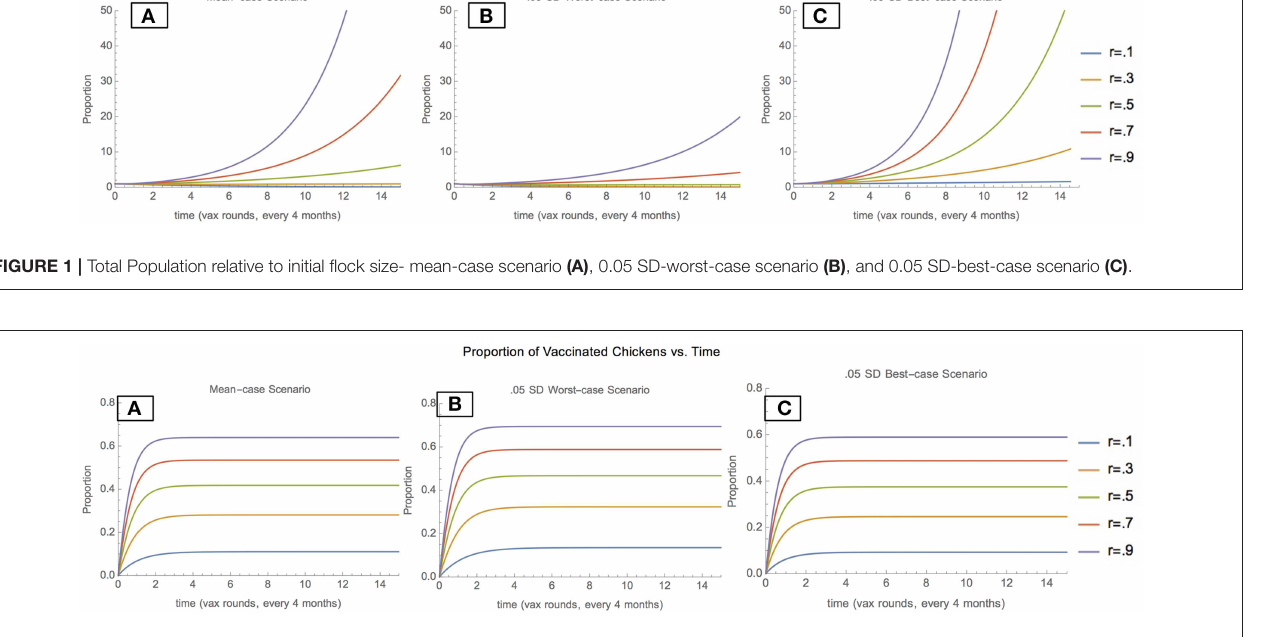
FIGURE 2 | Proportion of vaccinated chickens: mean scenario (A) , 0.05 SD-worst scenario (B) , and 0.05 SD-best scenario (C) .